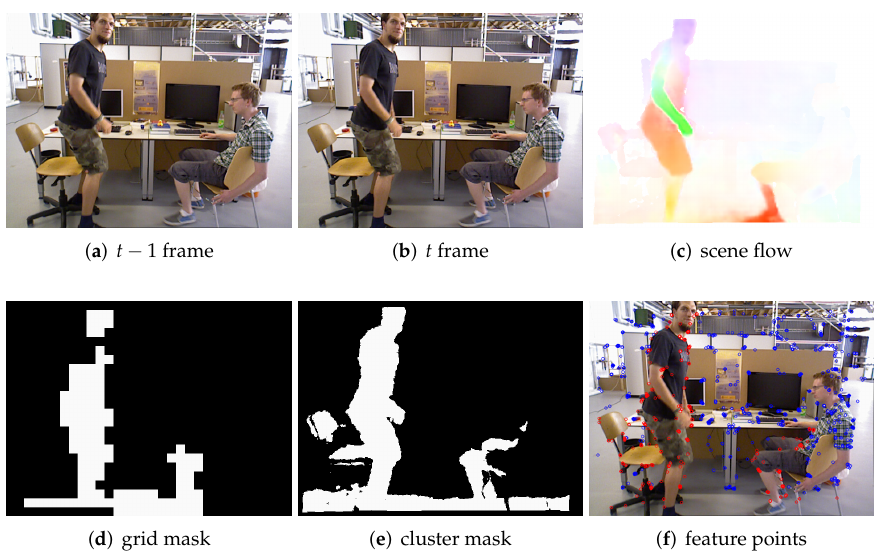
Figure 8. This figure shows an example of slight motion segmentation. ( a , b ) are frames at time t − 1 and time t , respectively, in which the human body is in slow motion. ( c ) is a scene flow graph.